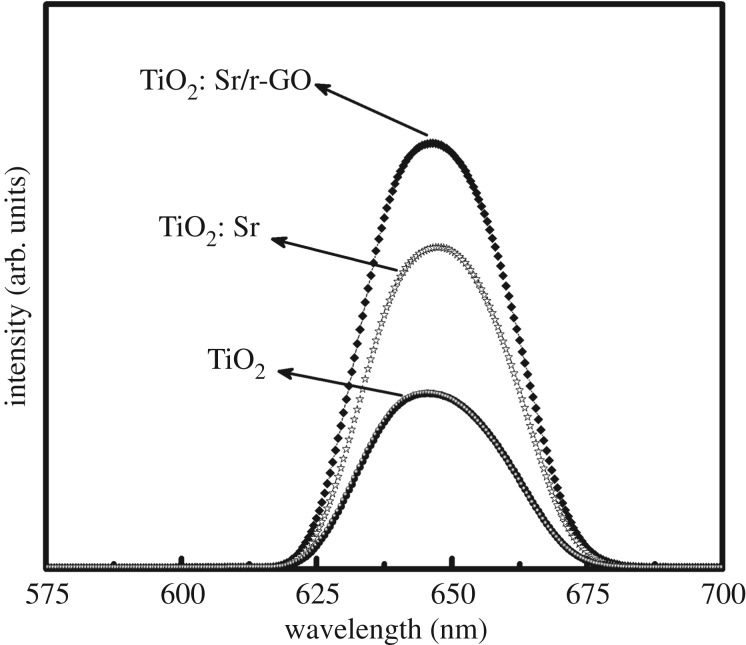
Photoluminescence of TiO2, TiO2: Sr, TiO2: Sr/r-GO.